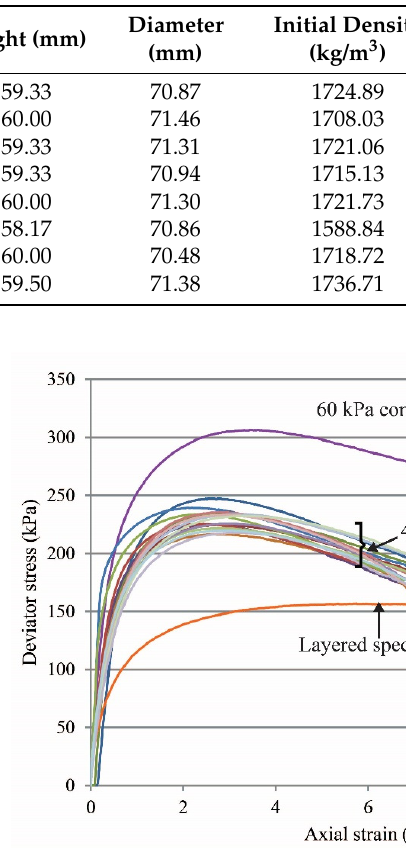
Figure 3. Global stress ‐ strain responses of sand specimens prepared by the vibratory compaction method.